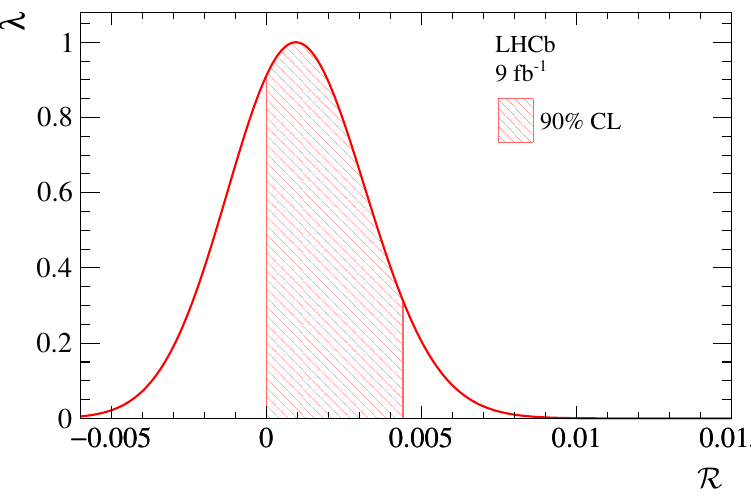
Figure 4. Smeared profile likelihood ratio curve from the simultaneous fit to the Run 1 and Run 2 data samples. The red shaded area indicates the 90% crediblity interval of R